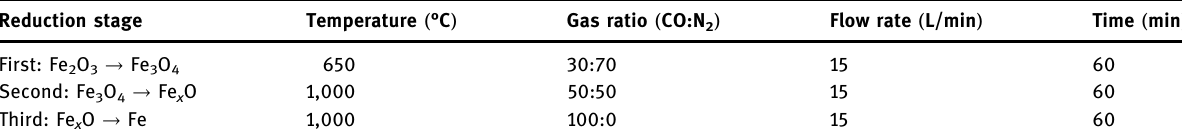
Table 3: Parameter settings for each reduction stage Reduction stage